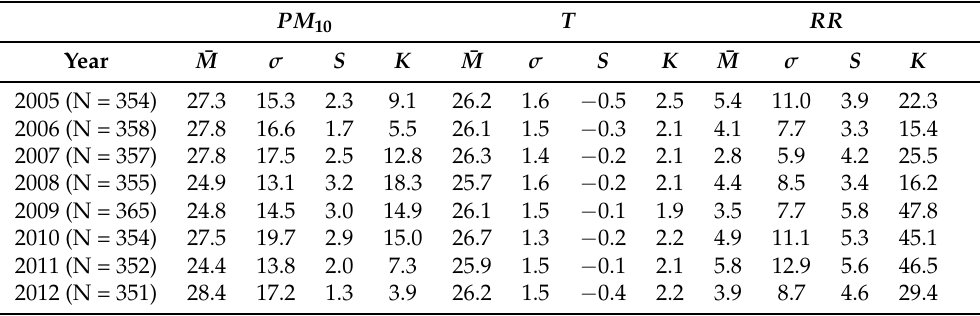
Table 1. The arithmetic mean ( ¯ M ), standard deviation ( σ ), skewness ( S ), and kurtosis ( K ) of PM 10 , T , and RR by year. For PM 10 - T - RR , ¯ M and σ are, respectively, in µ g/m 3 - ◦ C-mm, while N is the sample